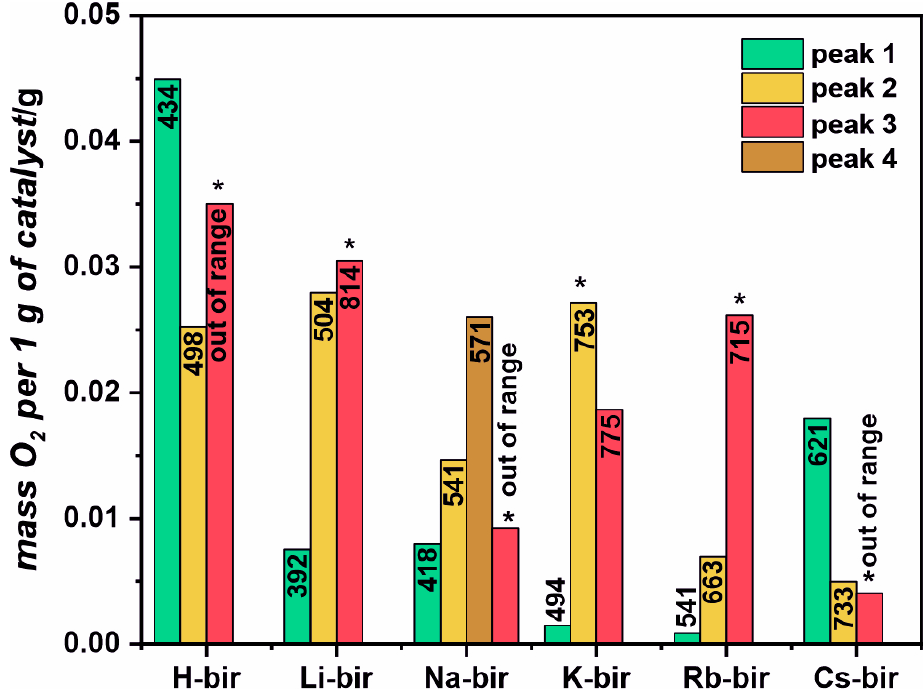
Figure 3. The amounts of oxygen released from the samples at different temperatures. The numerical values in the bars indicate the maximum desorption peak (or out of range). * denotes that the peak continues to higher temperatures. The relative amounts were calculated based on the Gaussian peaks fitted in Figure S6; the absolute amounts were calculated based on the thermogravimetric mass changes due to the oxygen released from the samples.